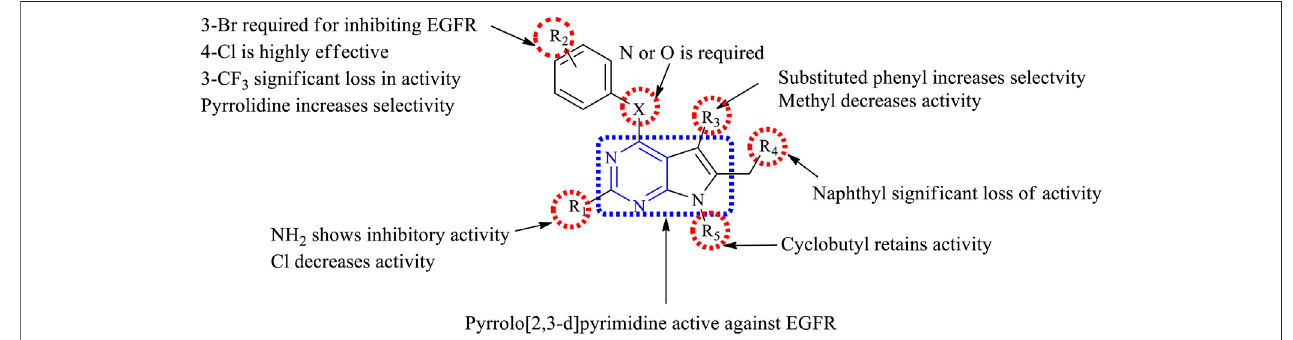
FIGURE 11 | Summary SAR of trisubstituted